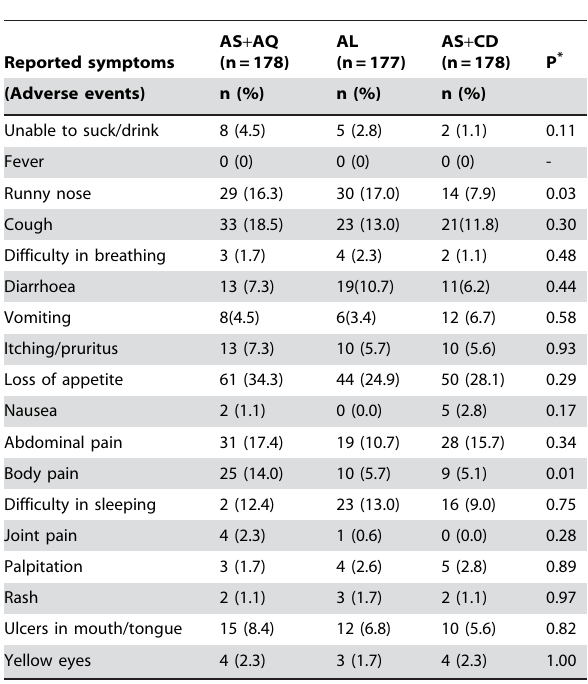
Table 6. Treatment outcomes in G6PD deficient children (Per protocol